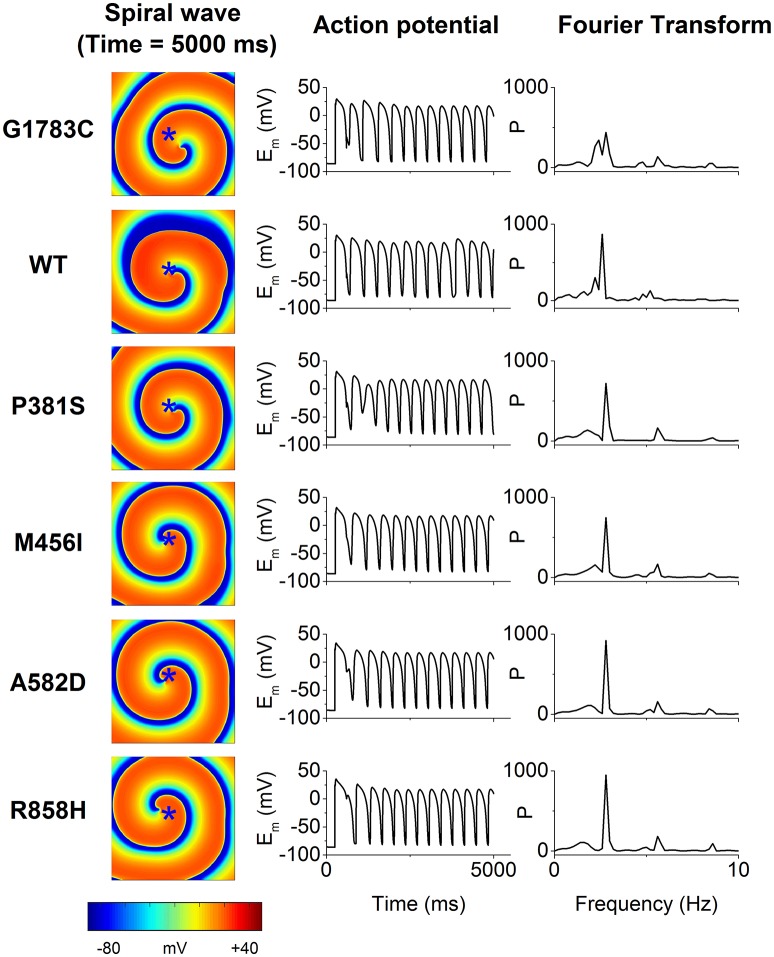
The spiral wave (Time = 5,000 ms, left column), action potential (Em, middle column) and temporal Fourier transforms of Em (right column) for the G1783C, wild-type (WT), P381S, M456I, A582D, and R858H conditions. Action potential recorded from a representative point (x = 187.5 mm, y = 187.5 mm) that is marked by an asterisk.